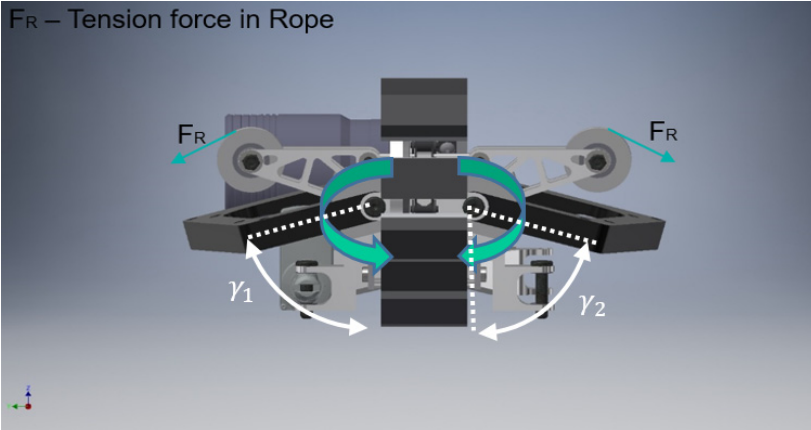
Figure 8. Front-view of the CRR crawler; arrows indicate circular tower alignment .